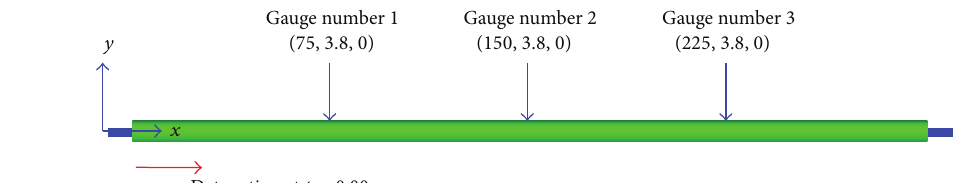
Figure 15: Gauges position.